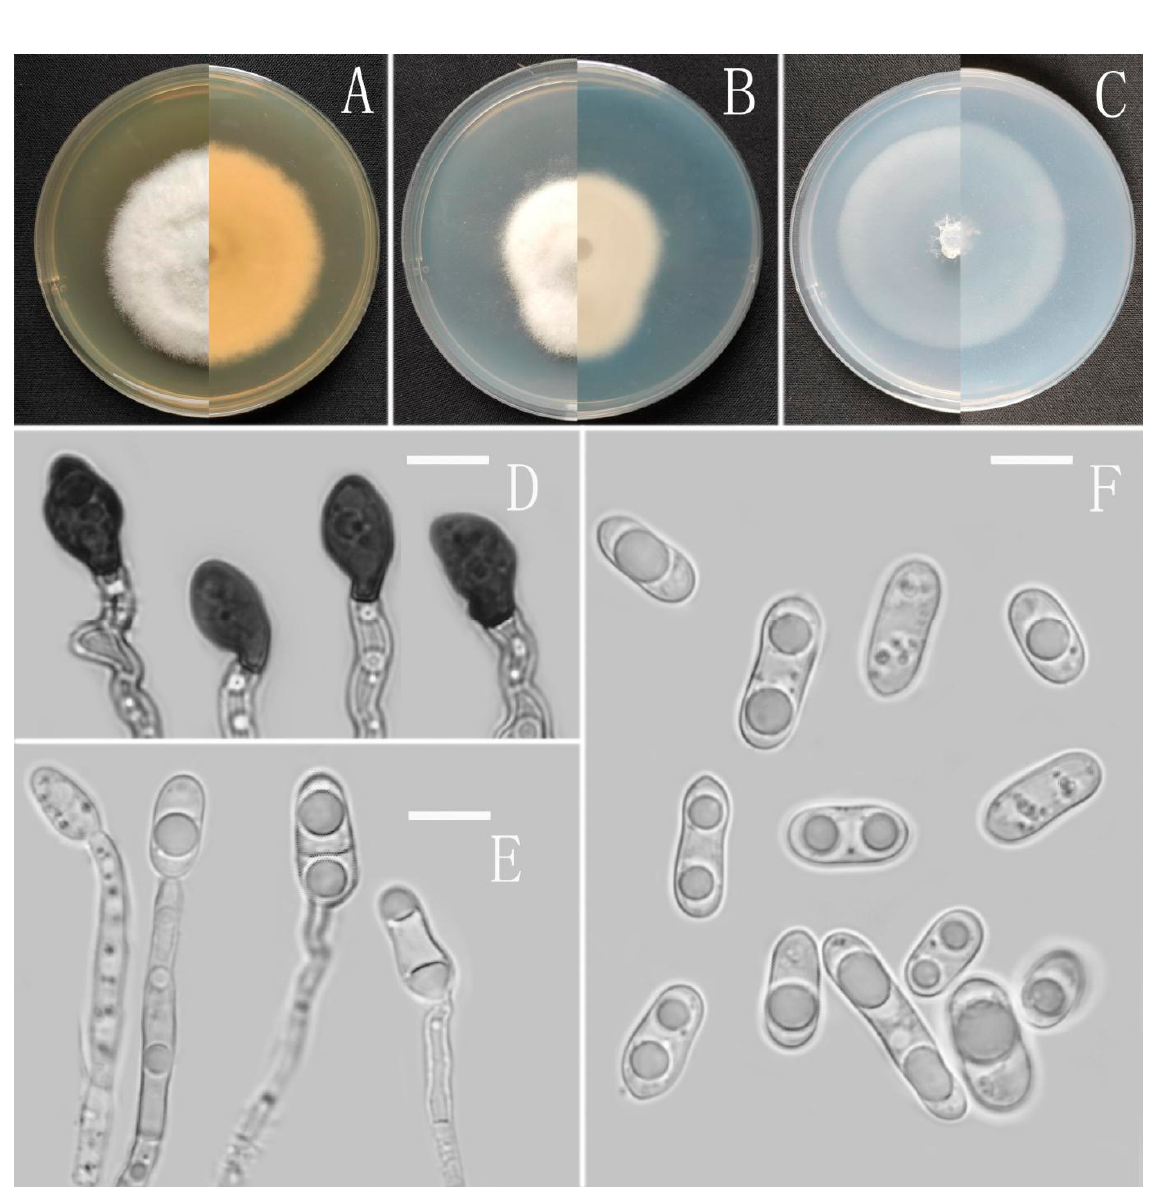
Figure 10. Colletotrichum parvisporum (YMF1.06942). ( A – C ) Colonies on media above and below after 7 days at 25 °C (( A ) MEA; ( B ) PDA; ( C ) SNA). ( D ) Appressoria. ( E ) Conidiophores. ( F ) Conidia. Scale bars: ( D – F ) = 10 μ m.